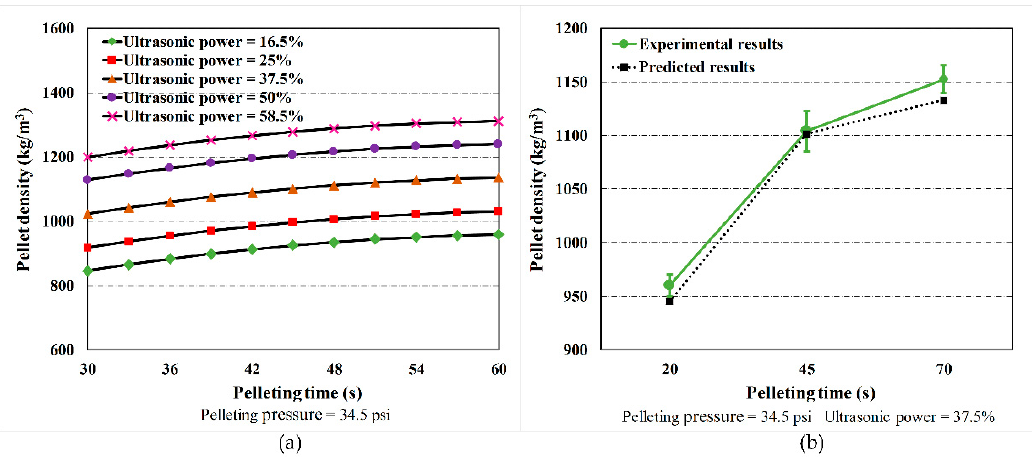
Figure 2. The effects of pelleting time on the pellet density. ( a ) The predicted pellet density at different levels of ultrasonic power (ranging from 16.5% to 58.5%) as the pelleting pressure was fixed to 34.5 psi (237,869.1 Pa) and the pelleting time increased from 30 s to 60 s. ( b ) For the pellet density, the comparison between the model results and experimental results at various levels of pelleting time (mean value ± SD).